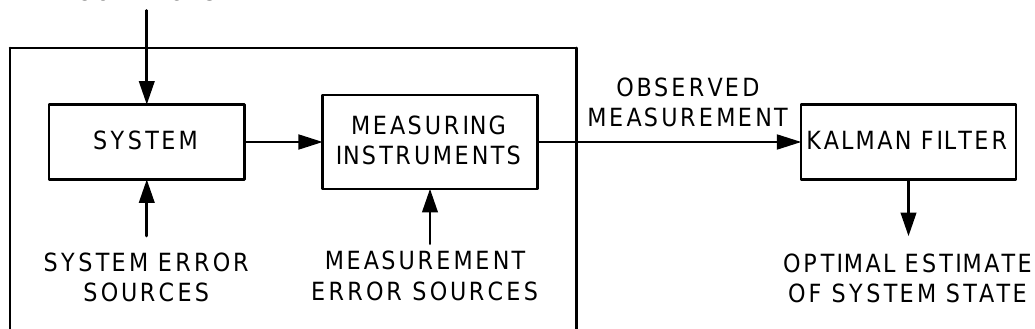
Figure 5. Typical Kalman Filter (KF) application block diagram (adapted from [112]).